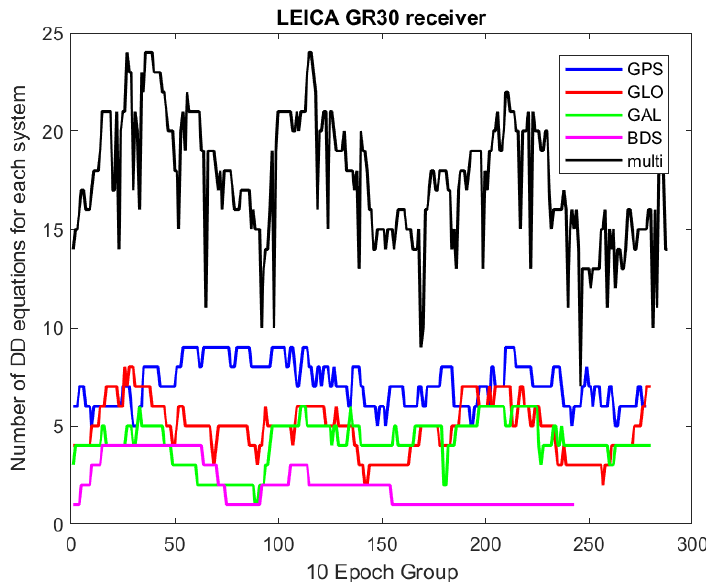
Figure 1. Number of DD equations for each system in 10 epoch group